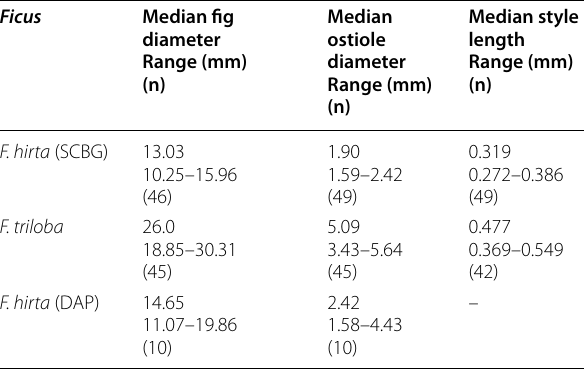
Table 2 Functional morphological features of receptive phase male figs of Ficus hirta at sites SCBG and DAP and Ficus triloba at site